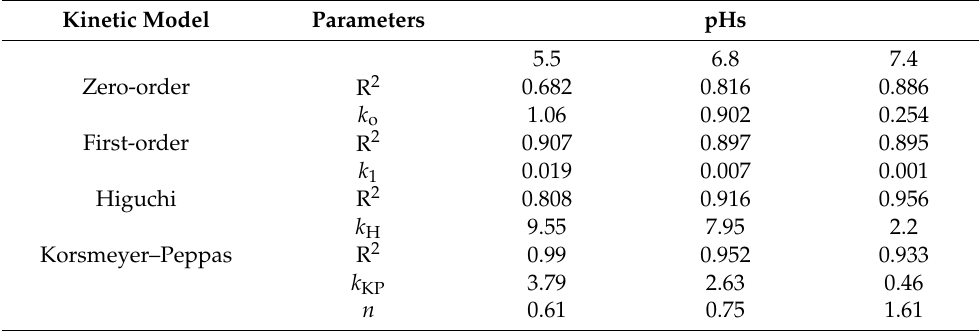
Table 2. Release parameters of different kinetic models for DOX at different pHs.